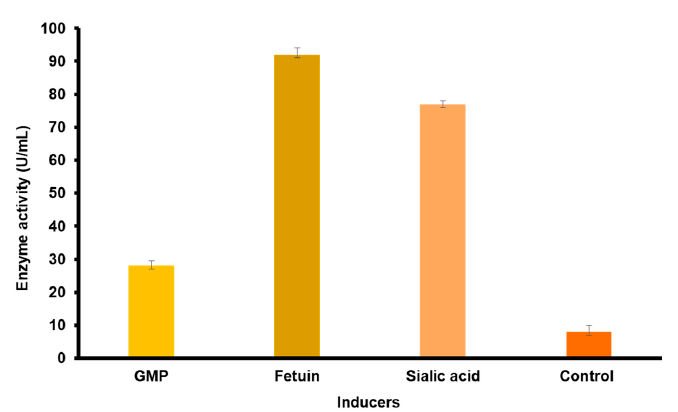
Figure 4. Substrate specificity of the sialidase isolated from O. paurometabola O129.